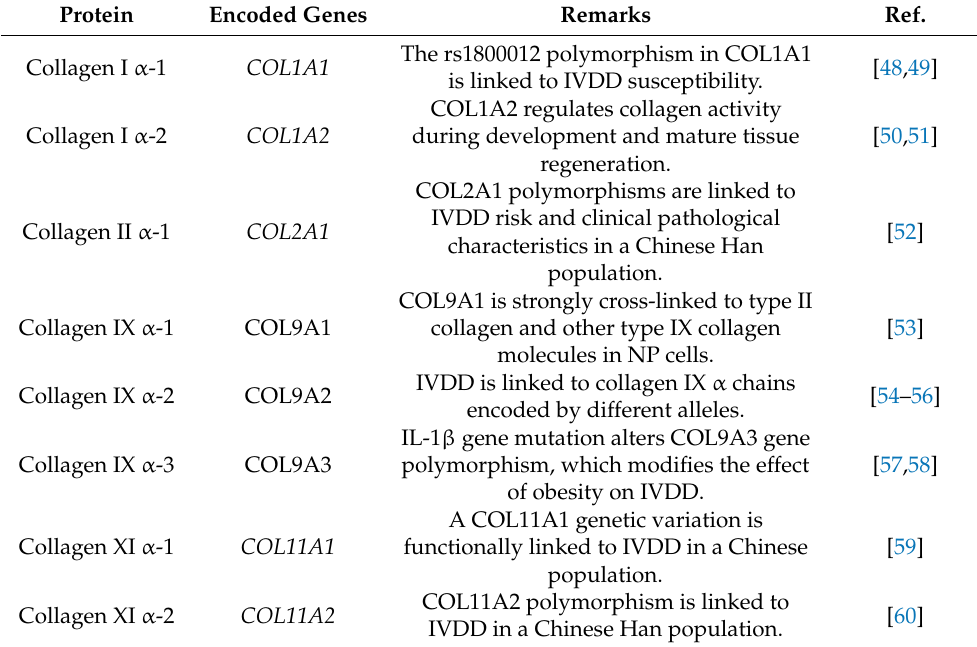
Table 1. ECM synthesis-related collagen genes associated with IVDD.